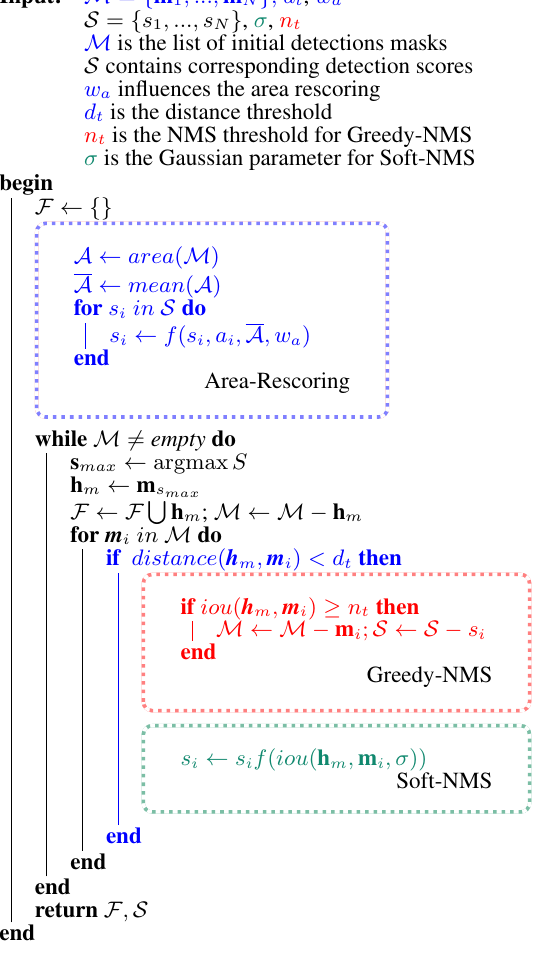
Figure 2. The Pseudocode of our proposed approach is similar to greedy-NMS or soft-NMS. The main difference is utilizing instance masks M instead of bounding boxes B